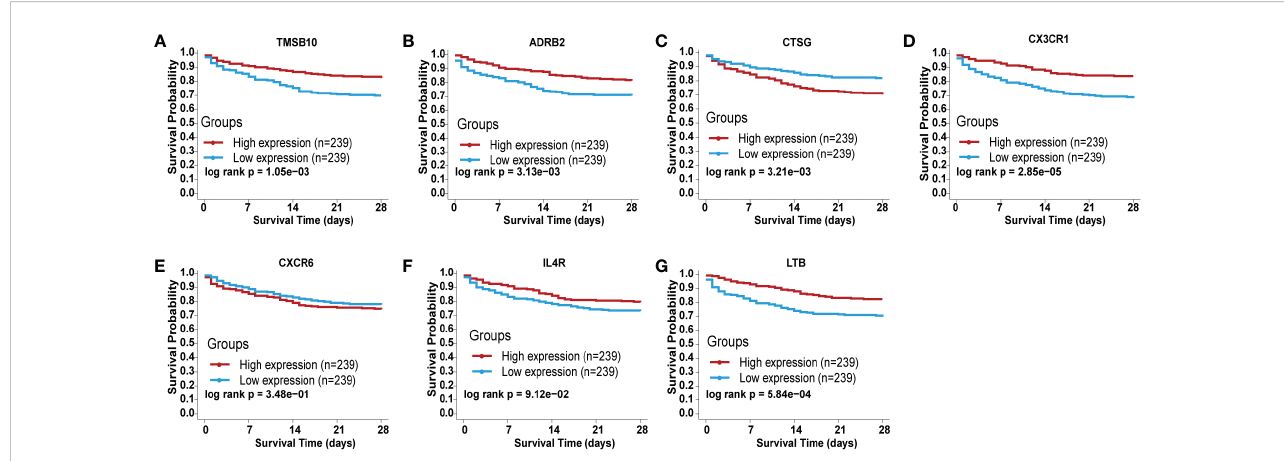
FIGURE 4 Validation of the independent prognostic ef fi ciency for individual mRNA in the 7-immune gene signature based on the BIDOS database. (A) ADRB2, (B) CTSG, (C) CX3CR1, (D) CXCR6, (E) IL4R, (F) LTB, and (G)